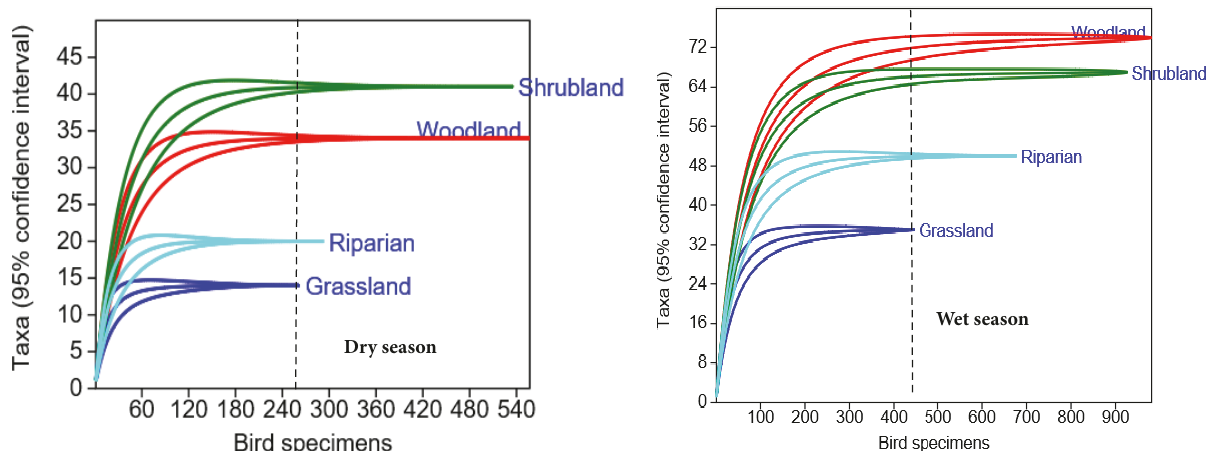
Figure 4: Standardized comparison of species richness for two individual-based rarefaction curves. The data represent summary counts of birds that were recorded from the four habitats in Mole National Park. The green, red turquois and blue lines are the rarefaction curves, calculated from (1) [53], with a 95% confidence interval. The dotted vertical lines illustrate a species richness comparison standardized to 262 (dry season) and 447 (wet season) individuals, which was the observed bird abundance in the smallest (grassland) of the four habitats bird data sets.